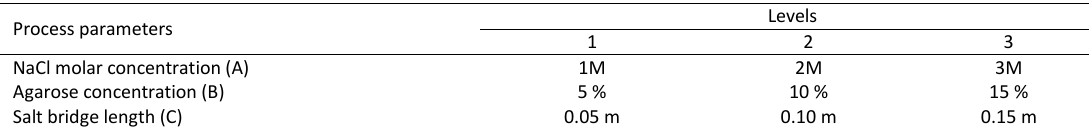
Table 2: Process parameters and their levels